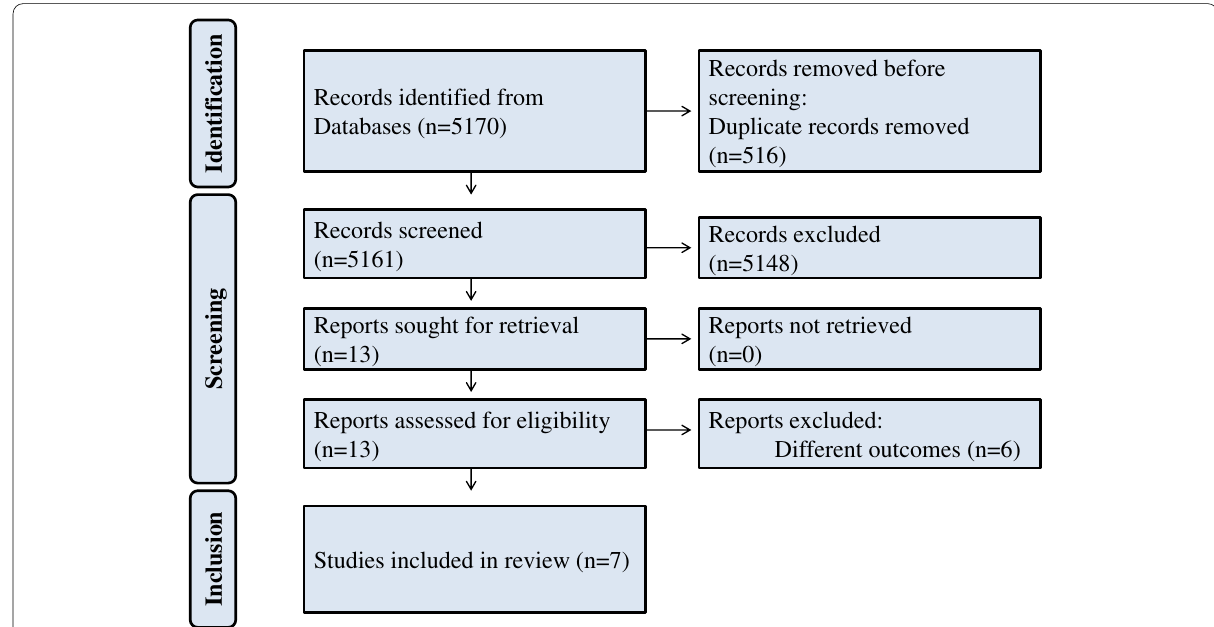
Fig. 1 PRISMA (Preferred Reporting Items for Systematic Reviews and Meta-Analyses)